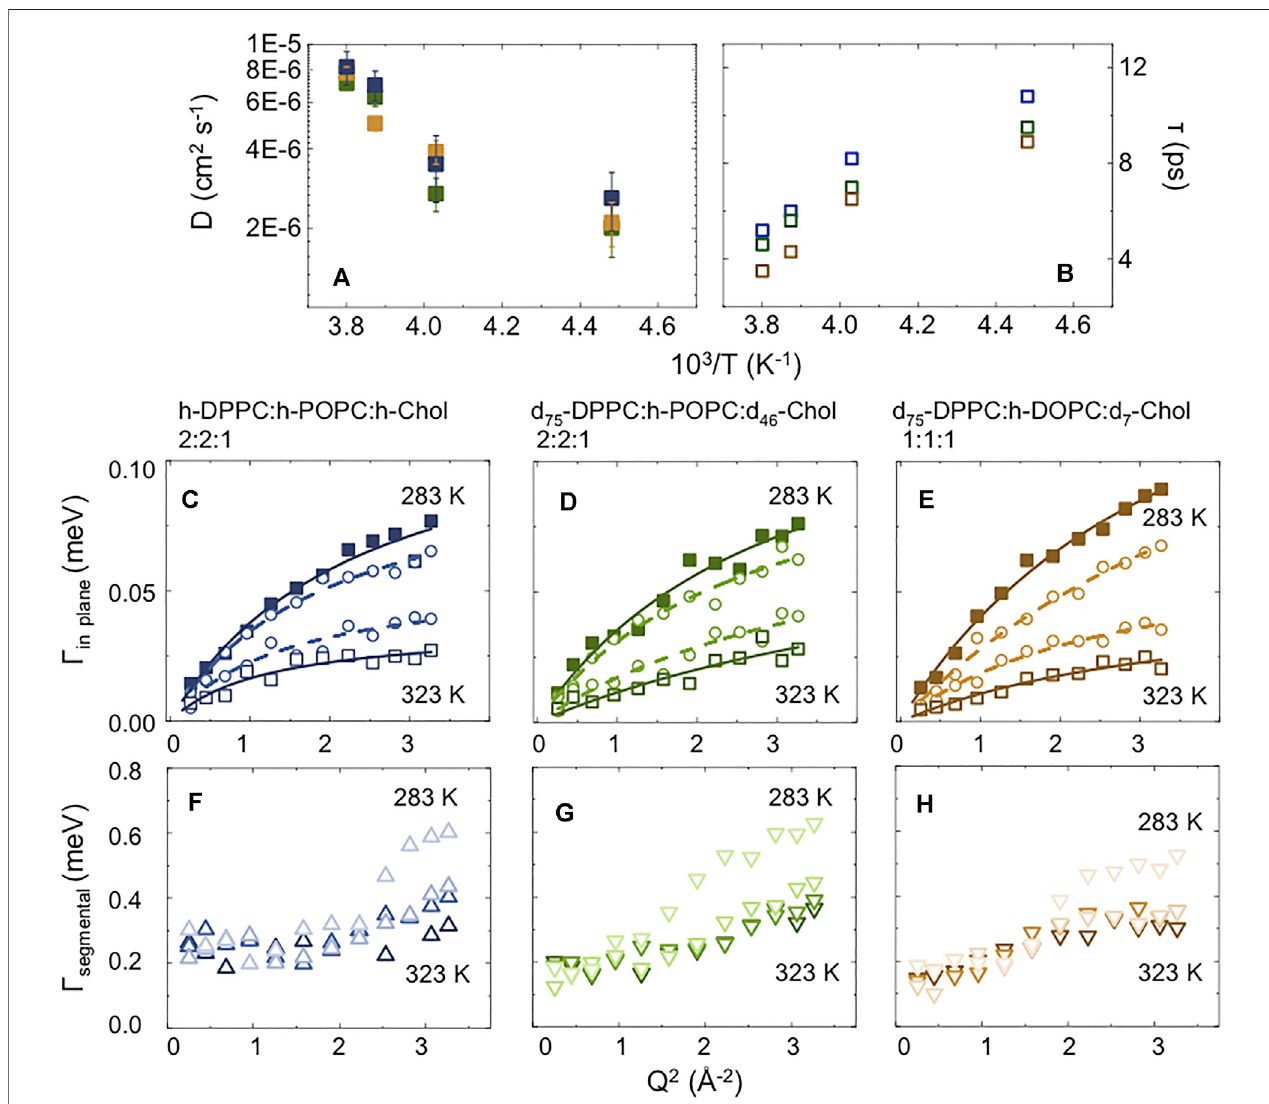
FIGURE 6 | Parameters extracted from the fi ts as a function of temperature (from 283 to 323 K) for 1) h-DPPC:h-POPC:h-Chol molar ratio 2:2:1 (blue); 2) d 75 - DPPC:h-POPC:d 46 -Chol molar ratio 2:2:1 (green) and 3) d 75 -DPPC:h-DOPC:d 7 -Chol molar ratio 1:1:1 (brown). (A,B) Comparison of “ in-plane ” diffusion coef fi cient (A) and relative residence time (B) ; (C – E) Γ ( Q 2 ) relative to the narrow Lorentzian component ( lateral diffusion ); (F – H) Γ ( Q 2 ) relative to the broad Lorentzian component ( segmental relaxation